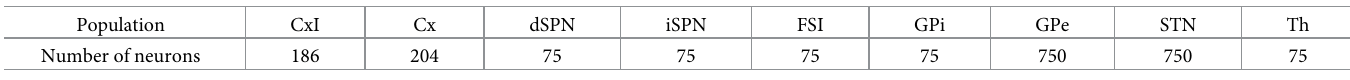
Table 1. Number of neurons in each population. The numbers corresponding to CxI and FSI are the total number of neurons. The other values correspond to neurons per channel.